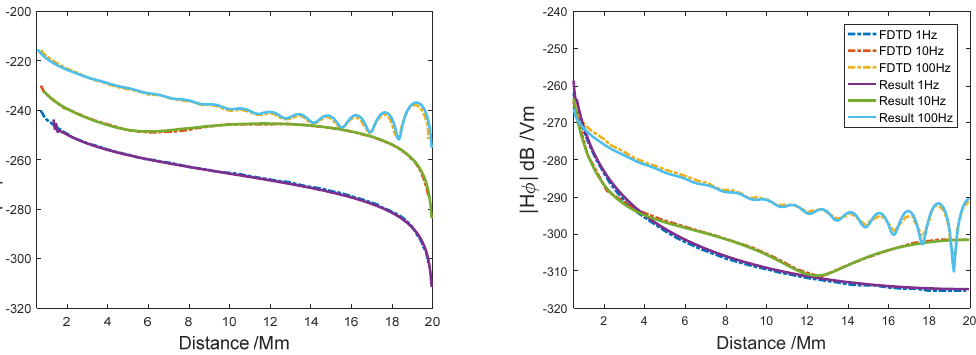
Figure 3. Field components | E r | and (cid:12) H ϕ (cid:12) versus the propagation distance, where the solid line represents the result calculated by the FDTD, and the dashed line represents the results of this paper.